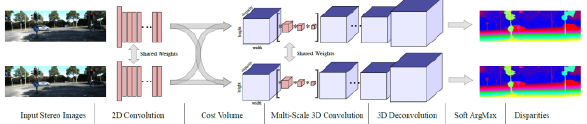
Figure 2. the network structure of GC-Net (cited from (Kendall et al.,